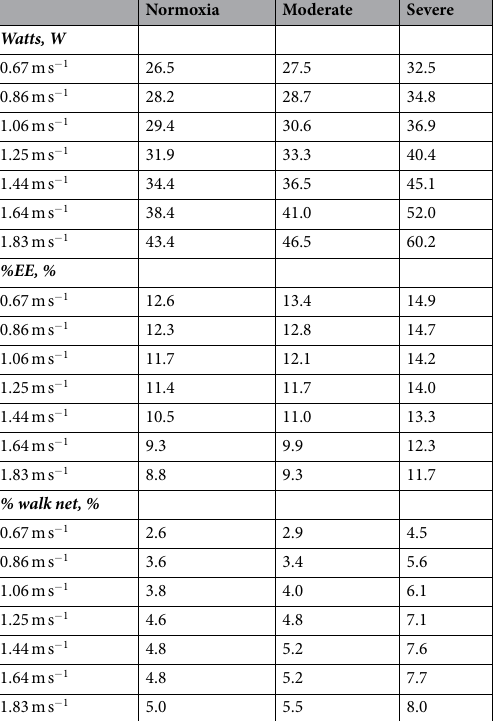
Normoxia Moderate Severe